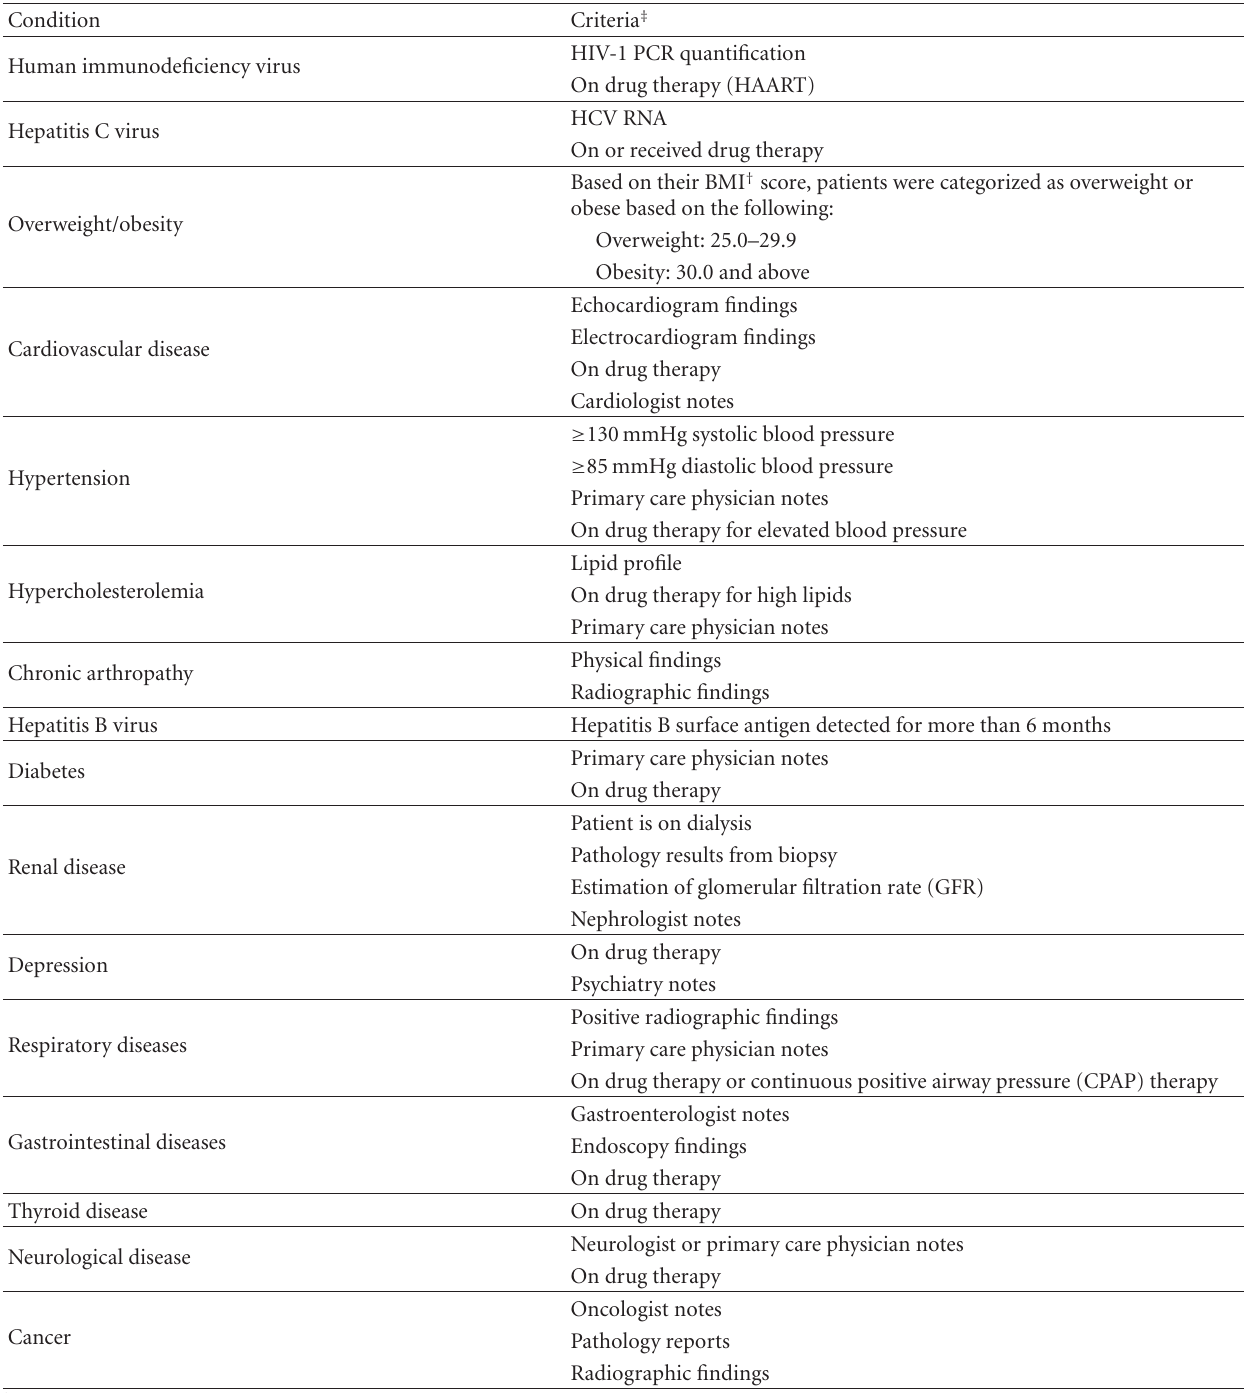
Table 1: Diagnostic criteria for defining co-morbid